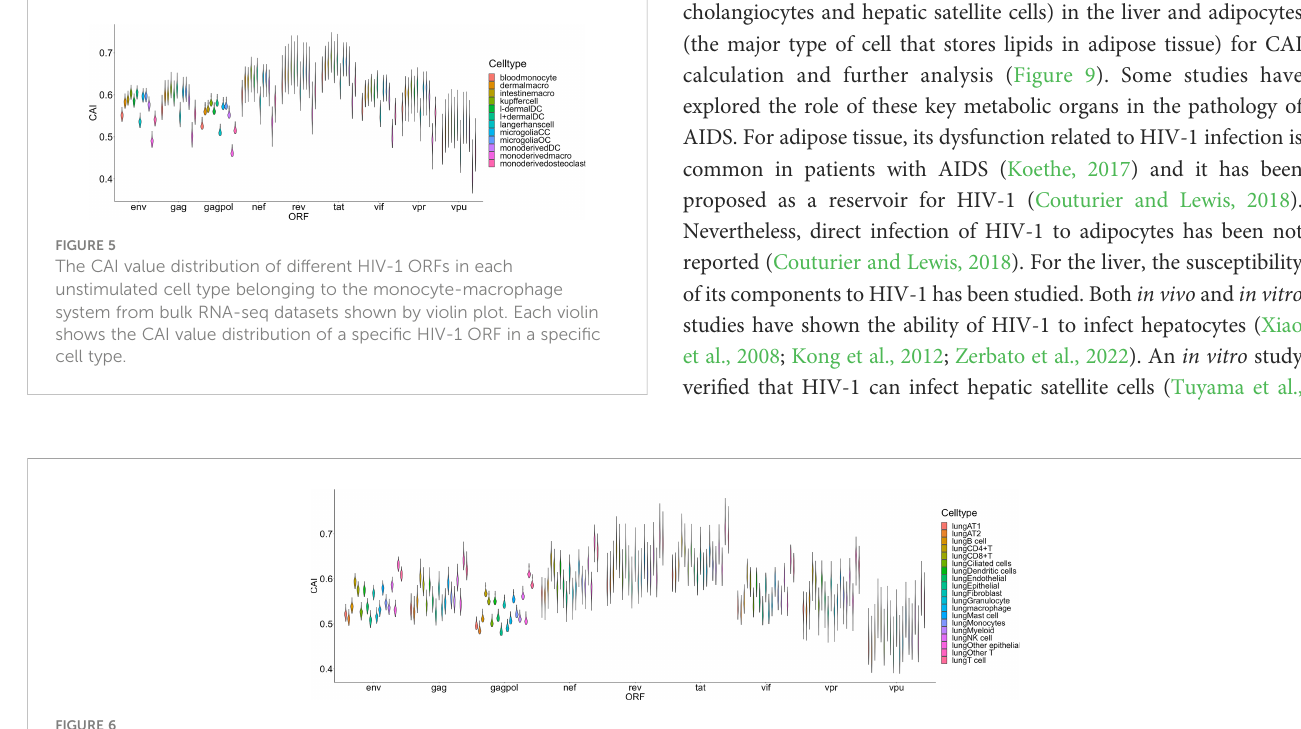
FIGURE 6 The CAI value distribution of different HIV-1 ORFs in each cell type/large group from the Smart-seq2 based lung scRNA-seq dataset shown by violin plot. Each violin shows the CAI value distribution of a speci fi c HIV-1 ORF in a cell type/large